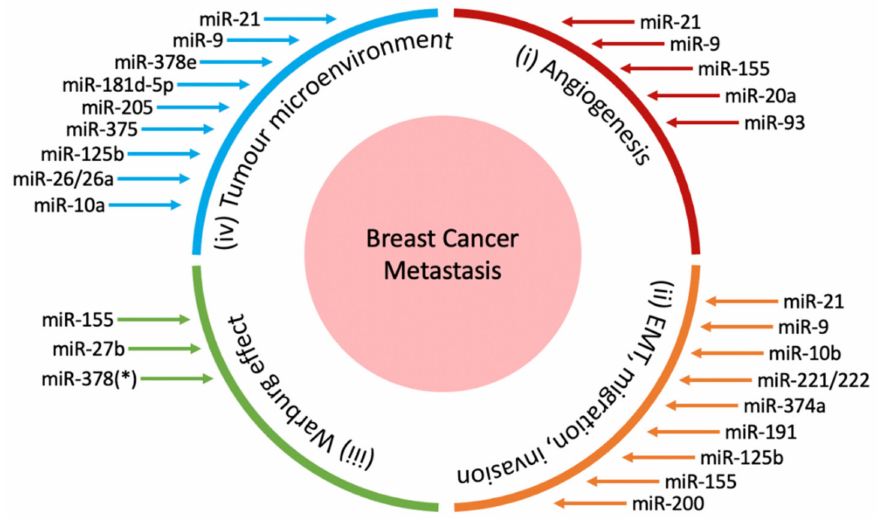
Figure 1. miRNAs involved in potentiating various stages and events in breast cancer metas- tasis: ( i ) angiogenesis, ( ii ) EMT, migration and invasion, ( iii ) the Warburg effect, and ( iv ) the tumour